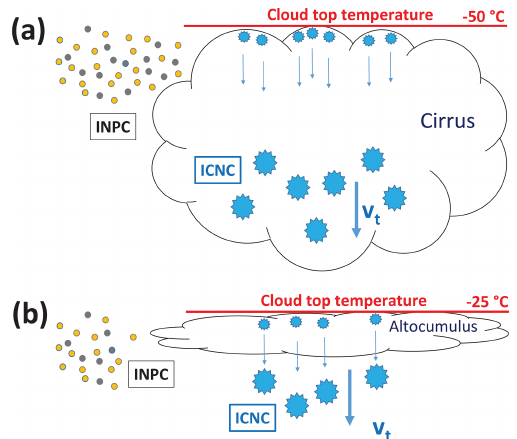
Figure 3. Illustration of the INPC–ICNC closure approach for (a) a vertically deep cirrus cloud and (b) a shallow stratiform mixed- phase altocumulus layer. In the first step, the INPC is retrieved from polarization lidar observations outside the cloud layer (e.g., before the cloud layer crosses the lidar field site). Gray and orange particles indicate continental pollution and mineral dust particles, respec- tively. In the second step, the ICNC is estimated from observations with the available backscatter lidar, Doppler lidar, and cloud radar instrumentations. Within the cirrus layer (a) the ICNC is preferably estimated in the lower part of the cloud with large ice crystals and thus clear falling features of ice crystals. v t is the mean terminal ve- locity of the ice crystal population relative to the surrounding air. In the case of a shallow altocumulus layer (b) , the ICNC is determined in the ice virga zone, below the main cloud layer in which backscat- ter by liquid droplets dominate the lidar return signals and prohibit ice observations. In the closure experiments, we assume that all ice crystals nucleate at the top of the cloud layer (at the coldest point of the cloud layer), grow quickly, and start falling and that the num- ber of nucleated ice crystals does not change on the way downward towards the lower part of the cirrus (a) and below the altocumulus layer (b) , i.e., that collisions of ice crystals and the subsequent for- mation of crystal aggregates as well as secondary ice production do not change the number of nucleated ice crystals